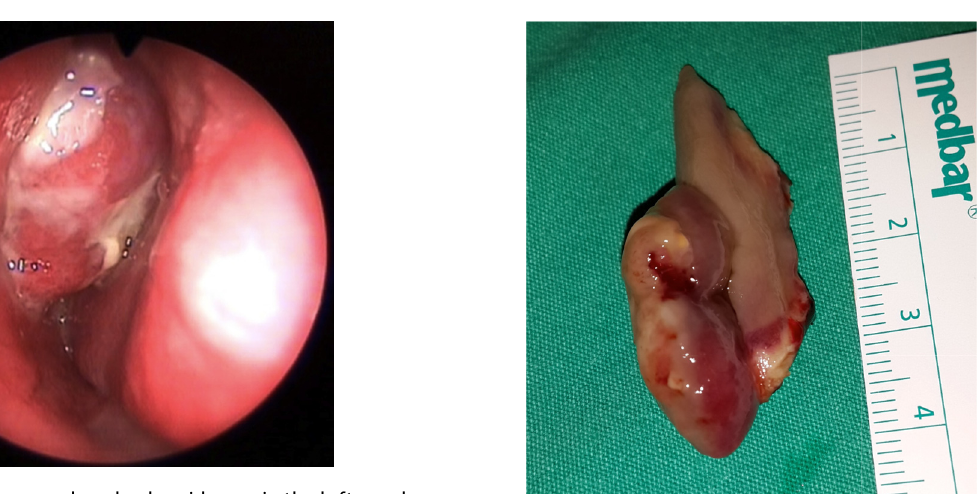
Figure 1 Reddish-gray-colored polypoid mass in the left nasal passage.